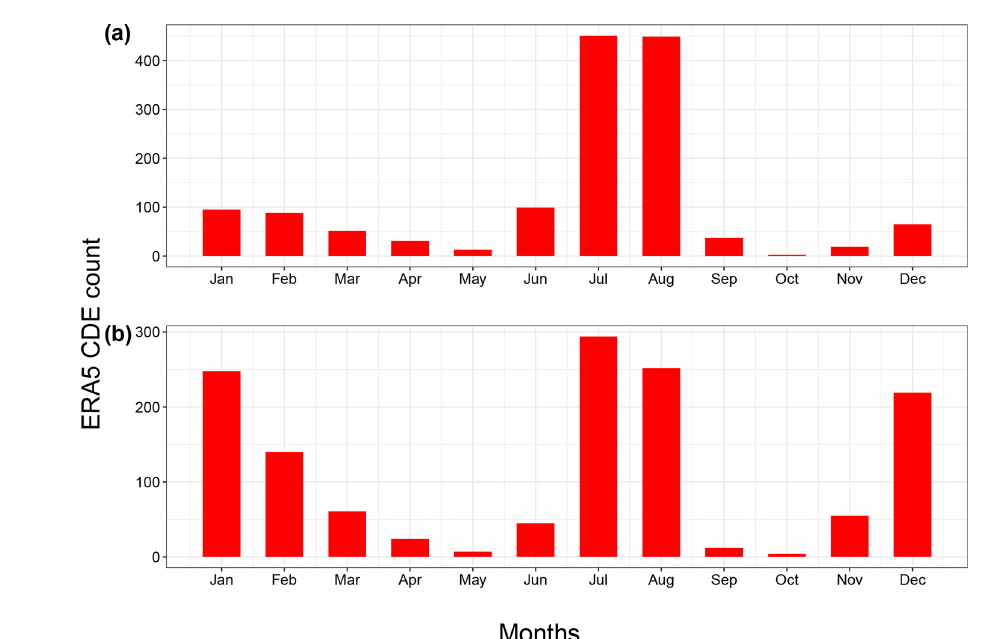
Figure 2. As Fig. 1c but for univariate local persistence of (a) T max ( θ